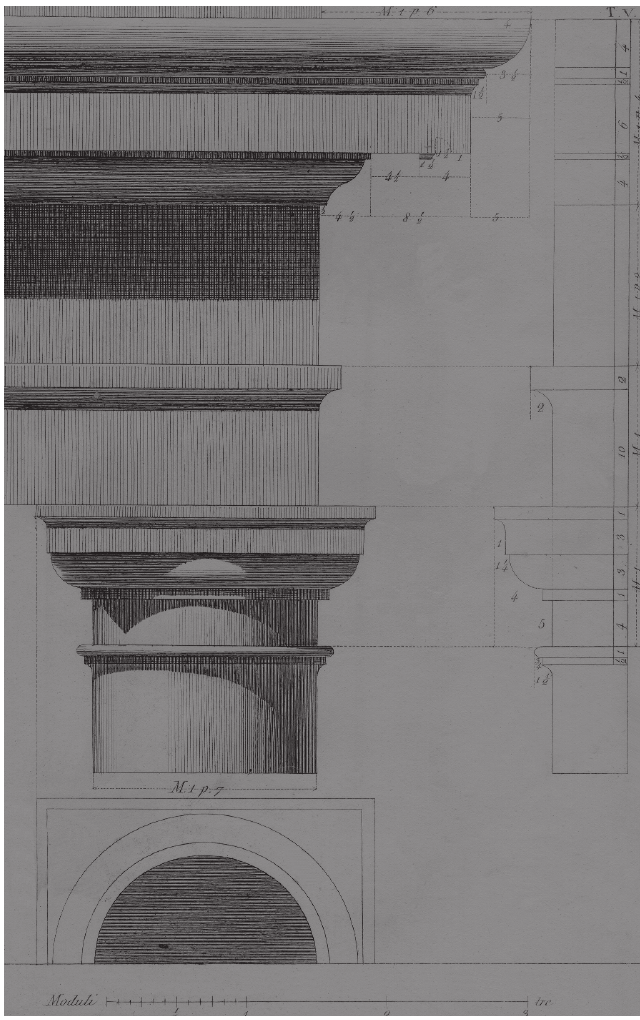
Fig. 3 Jacopo Barozzi da Vignola, Tuscan order (Barozzi da Vignola, 1889, plate